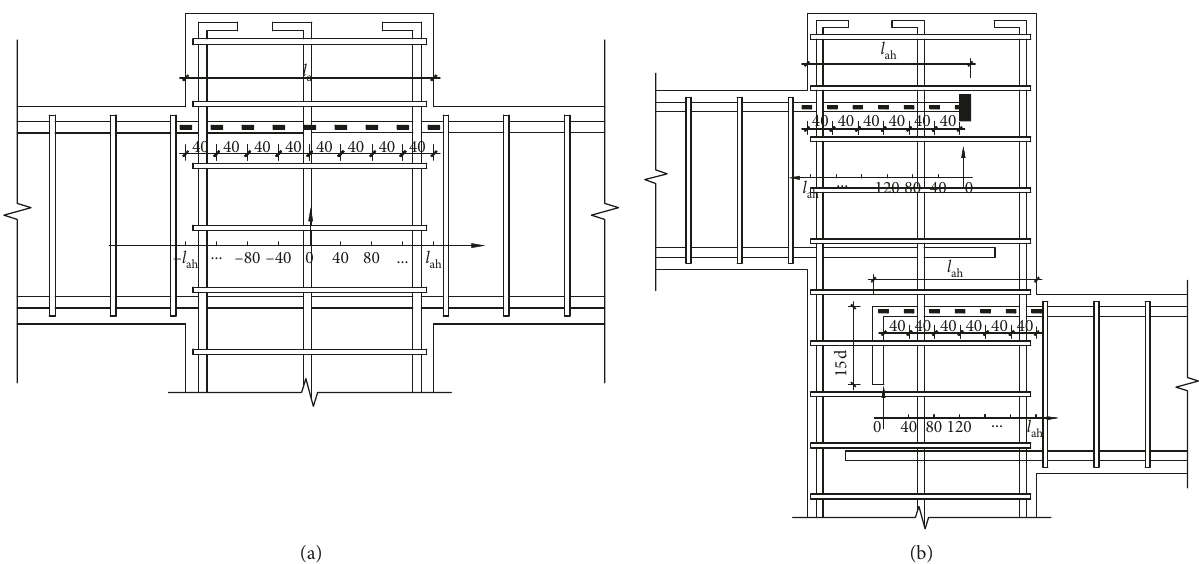
Figure 4: Configuration of strain gauges. (a) Interior beam-column connection. (b) Exterior beam-column connection.